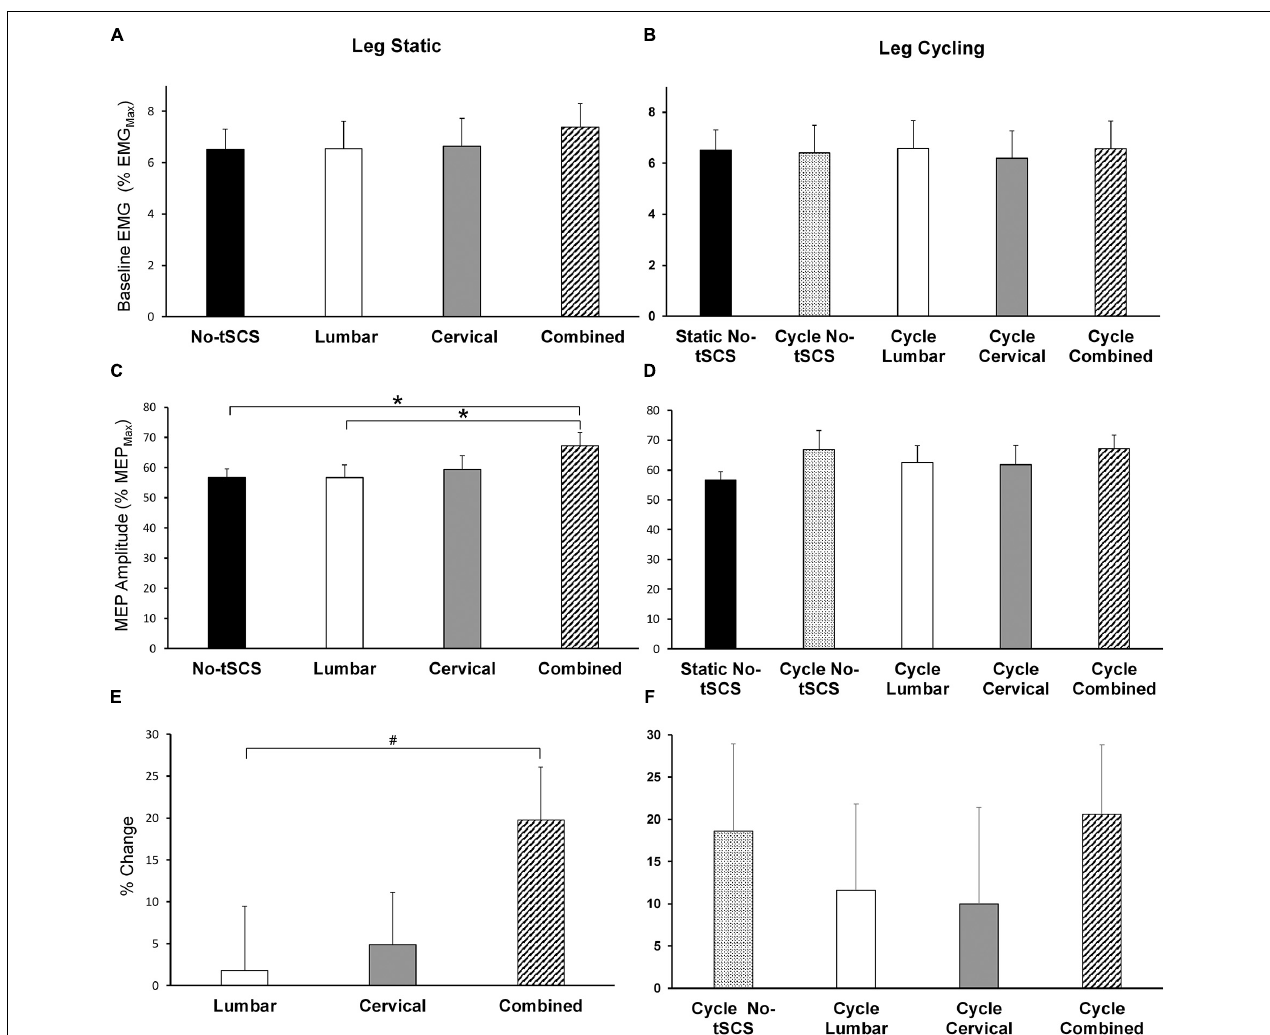
FIGURE 8 | Effect of tSCS on FCR MEP amplitude while the legs were static or cycling. Average amplitude of baseline activity during MEP assessments while the legs were (A) static and (B) cycling was similar across all conditions. (C) Average MEP peak-to-peak amplitude during tSCS while the legs were held static. Combined tSCS significantly increased the amplitude of the MEPs relative to No-tSCS and Lumbar tSCS. (D) Average MEP amplitude during tSCS while the legs were cycling. There was no significant difference in the amplitude of MEPs compared to the static, No-tSCS condition for all cycling conditions. (E) Percent increase in MEP amplitude during Lumbar, Cervical and Combined tSCS relative to the legs static, No-tSCS condition. The% increase in MEP amplitude with Combined tSCS was significantly larger than that with Lumbar tSCS. (F) Percent increase in MEP amplitude during leg cycling relative to the legs static, No-tSCS condition. * p < 0.05, # p = 0.056. Values are Mean ±